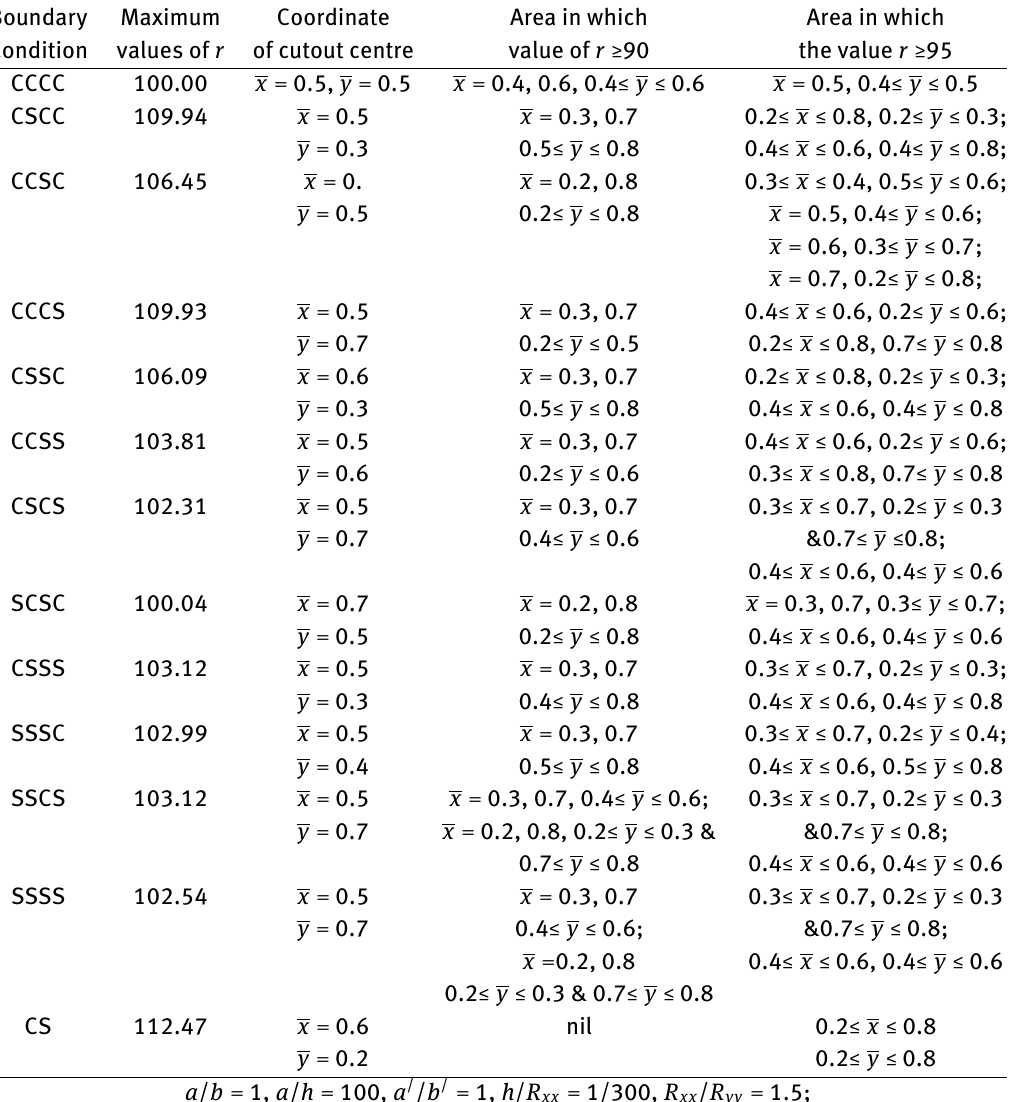
Table 10: Maximum values of r with corresponding coordinates of cutout centres and zones where r ≥ 90 and r ≥ 95 for + 45/-45/ + 45/-45 elliptic parabolic